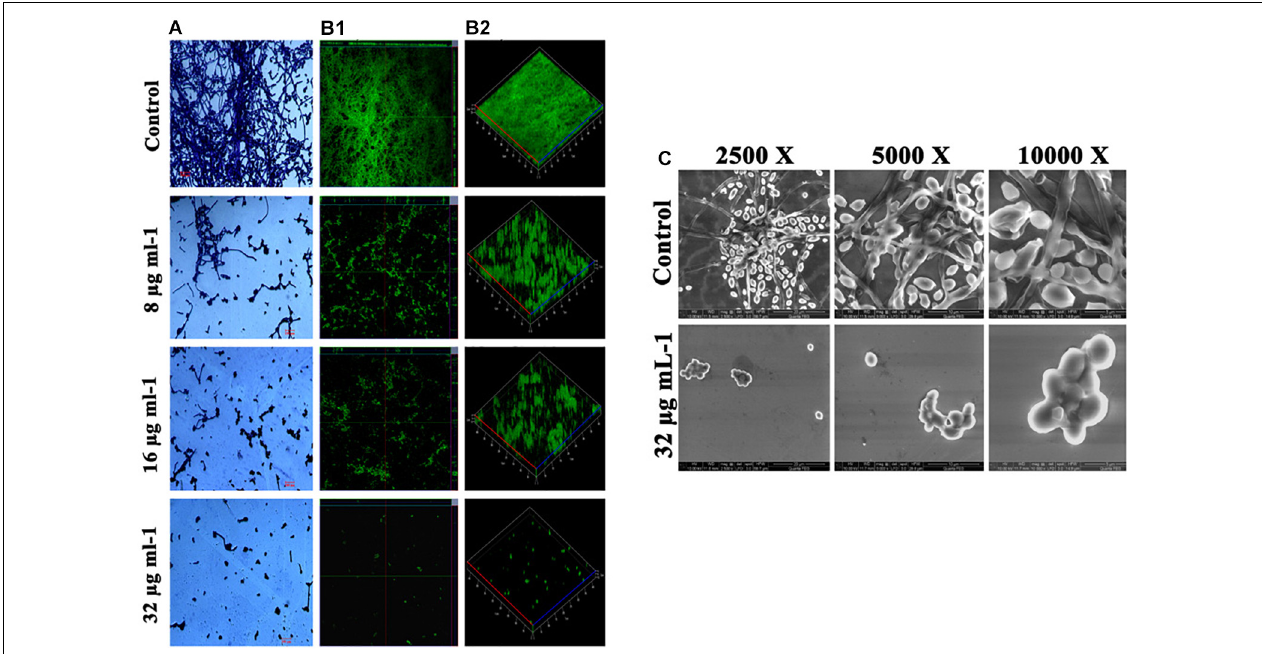
FIGURE 3 | Deterioration in the C. albicans surface adherence and hyphal development by piperine. (A) Light microscopic micrographs depicting decrease in the biofilm formation and hyphal development. (B-1,B-2) Biofilm architecture of C. albicans in ortho and 3D view, respectively. (C) SEM micrographs displaying the biofilm network of control and piperine-treated C. albicans under different magnifications.